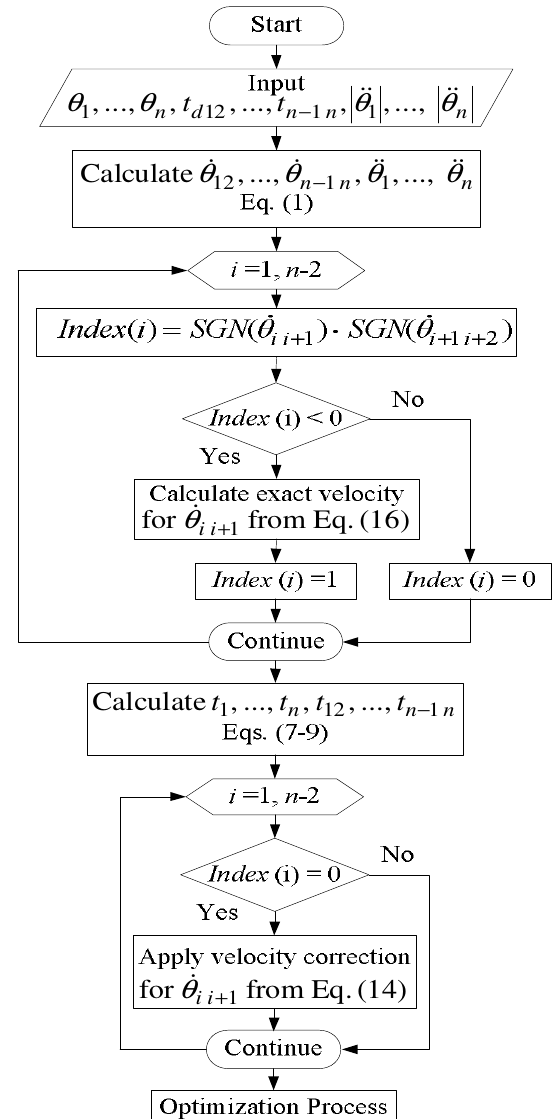
Fig. 3. Algorithm flowchart for proposed modified LSPB